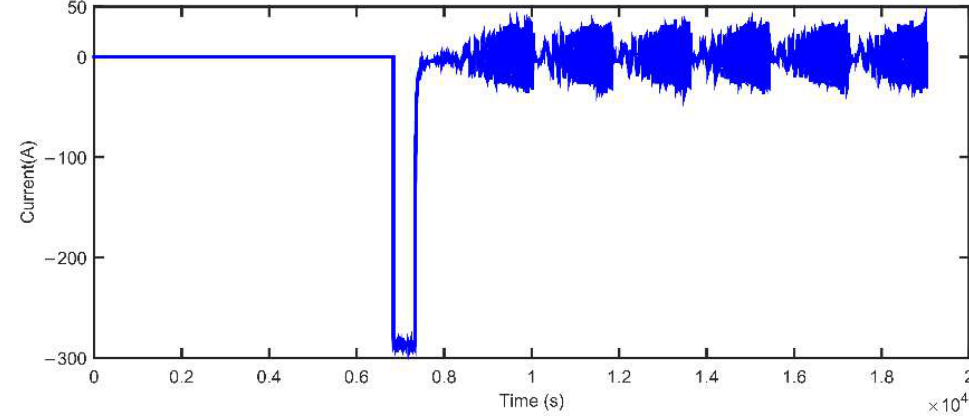
Figure 17. Dynamic condition test 2 experimental current.